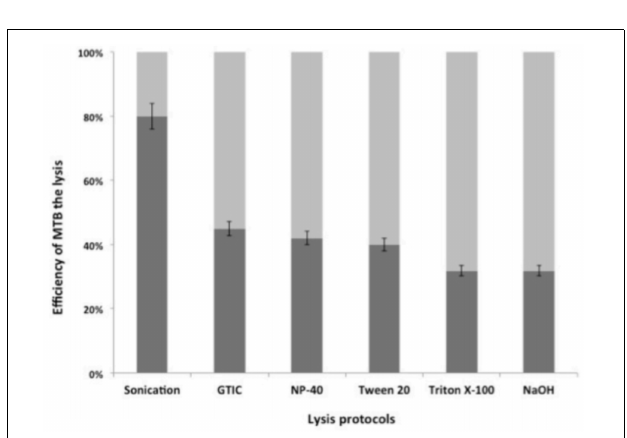
FIGURE 5 | Efficacy of MTB lysis using six different lysis methods combined with the Chelex R (cid:13) resin extraction. Each column represents average DNA copy number per microliter obtained in five independent experiment with three replicate reactions.